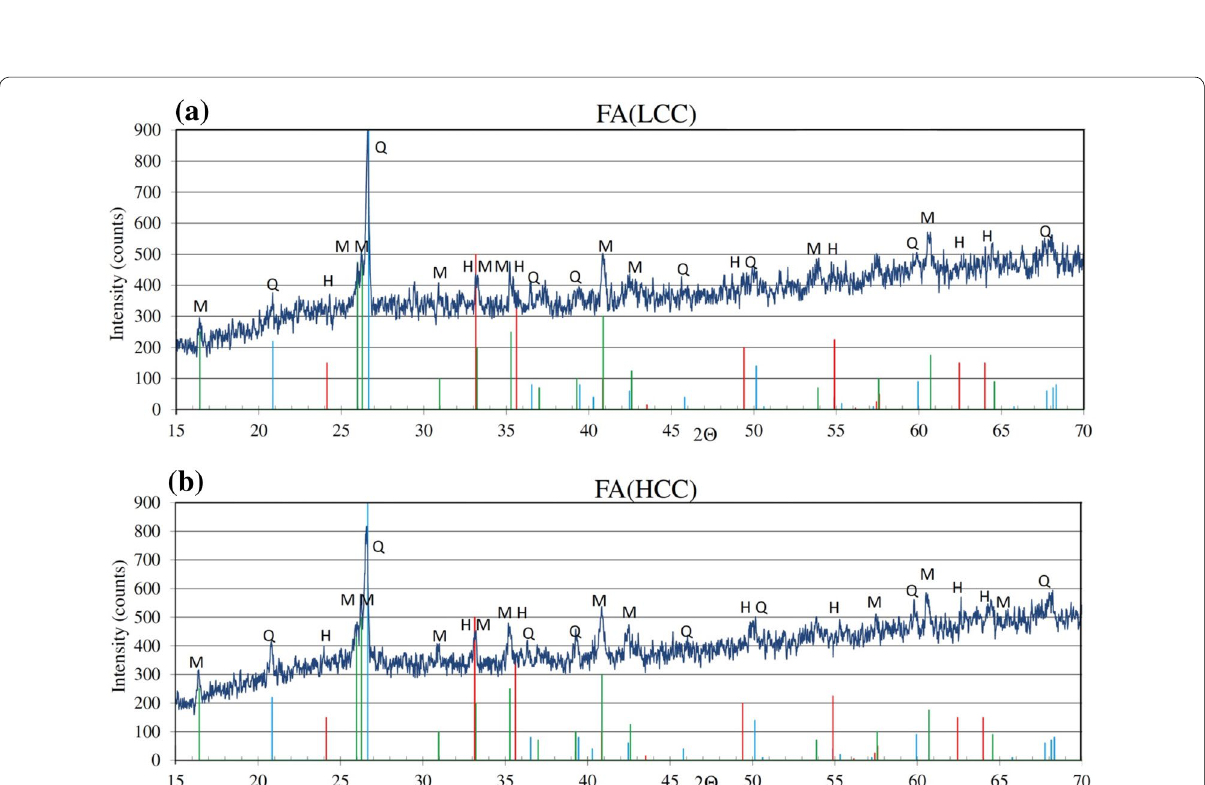
Fig. 2 Diffractograms of the investigated fly ashes: a FA(LCC) and b FA(HCC) (Q